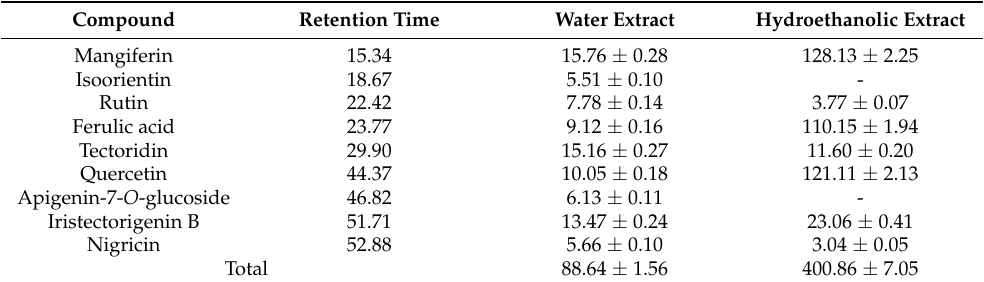
Table 5. The radical scavenging activity of individual compounds expressed as TEAC (mmol/g) between C. sativus perianth extracts using the ABTS post-column assay.